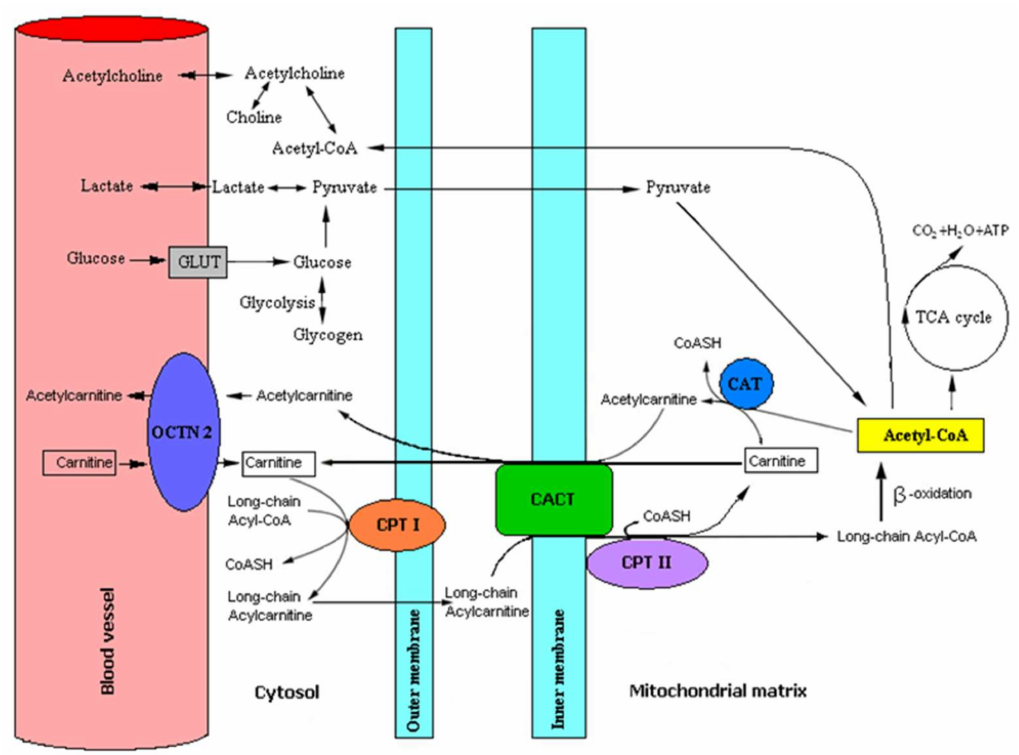
Figure 1. The role of carnitine and other substances in the brain’s energy supply. Abbreviations: GLUT, glucose transporters; OCTN2, sodium-dependent carnitine organic cation transporter; CPT I, carnitine palmitoyltransferase I; CPT II, carnitine palmitoyltransferase II; CACT, carnitine acylcarnitine translocase; CAT, carnitine acetyltransferase; CoASH, coenzyme A; Acetyl-CoA, acetyl coenzyme A; TCA cycle, tricarboxylic acid